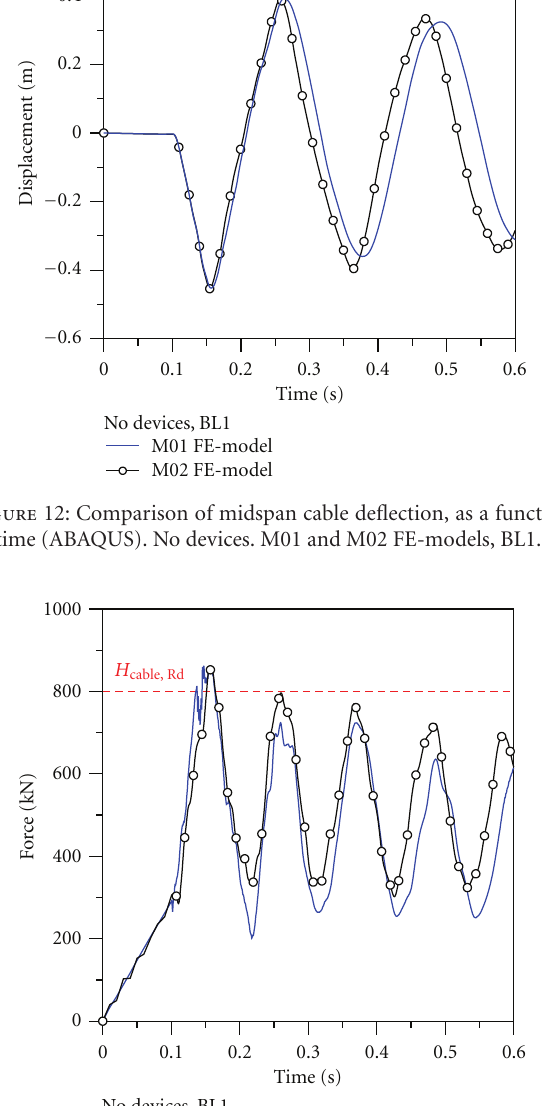
plane of the curtain wall, in the direction of the acting blast pressure (Figure 14(c),